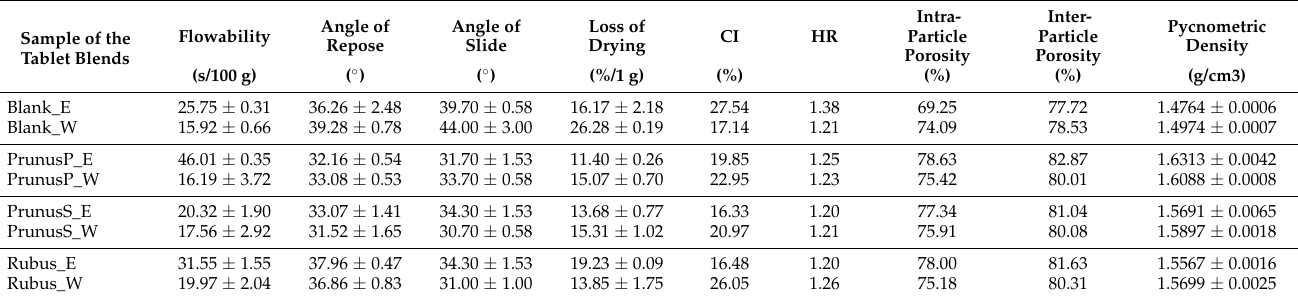
Table 3. Physical evaluation of the powder